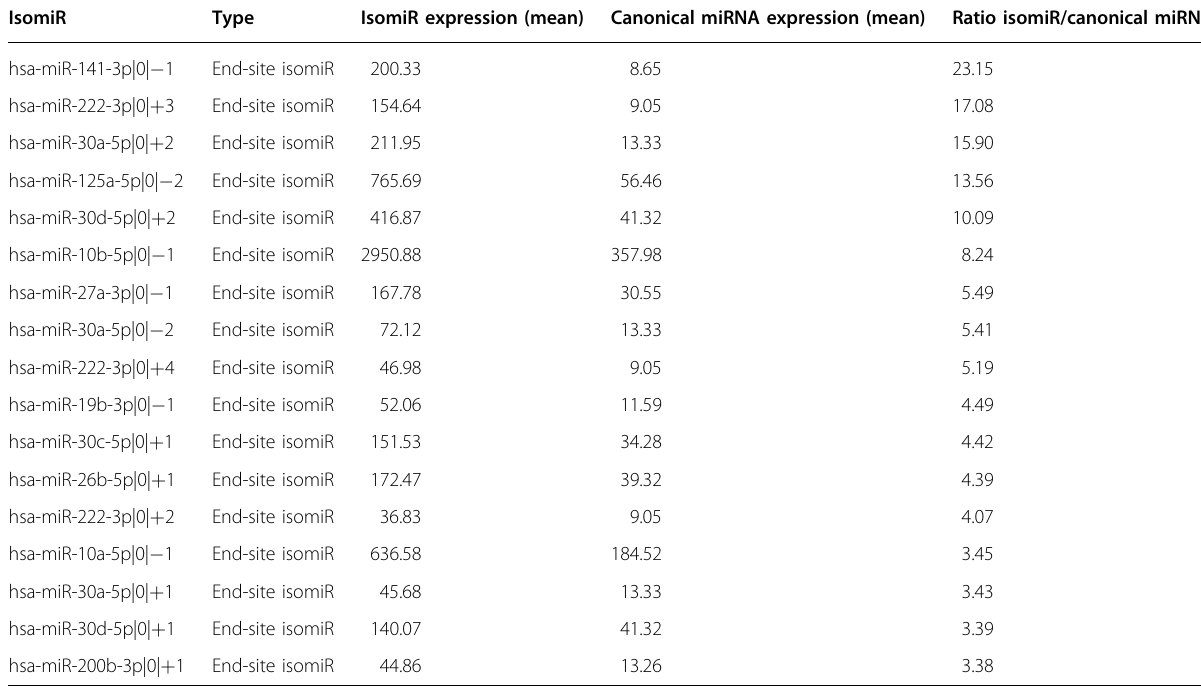
Table 2 IsomiRs most represented in melanoma and nevi small RNA-sequencing data. IsomiR